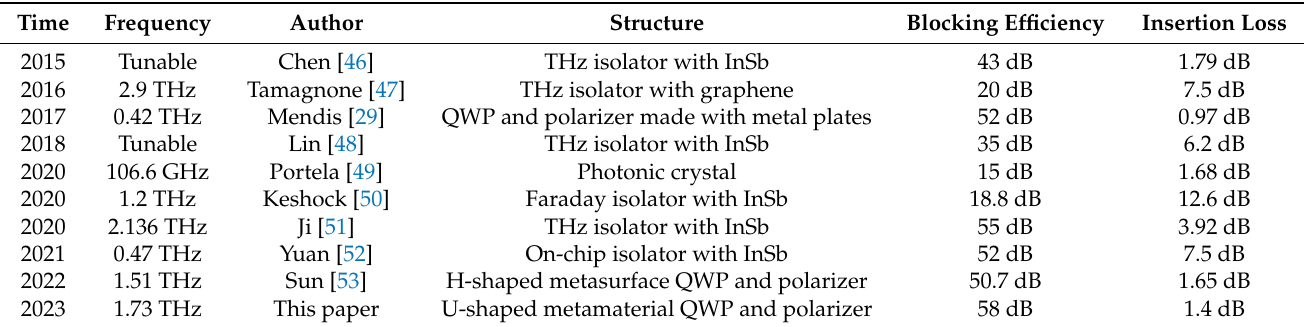
Table 1. Comparison of the blocking efficiency and insertion loss of several terahertz devices and solutions with backward reflection blocking or isolation